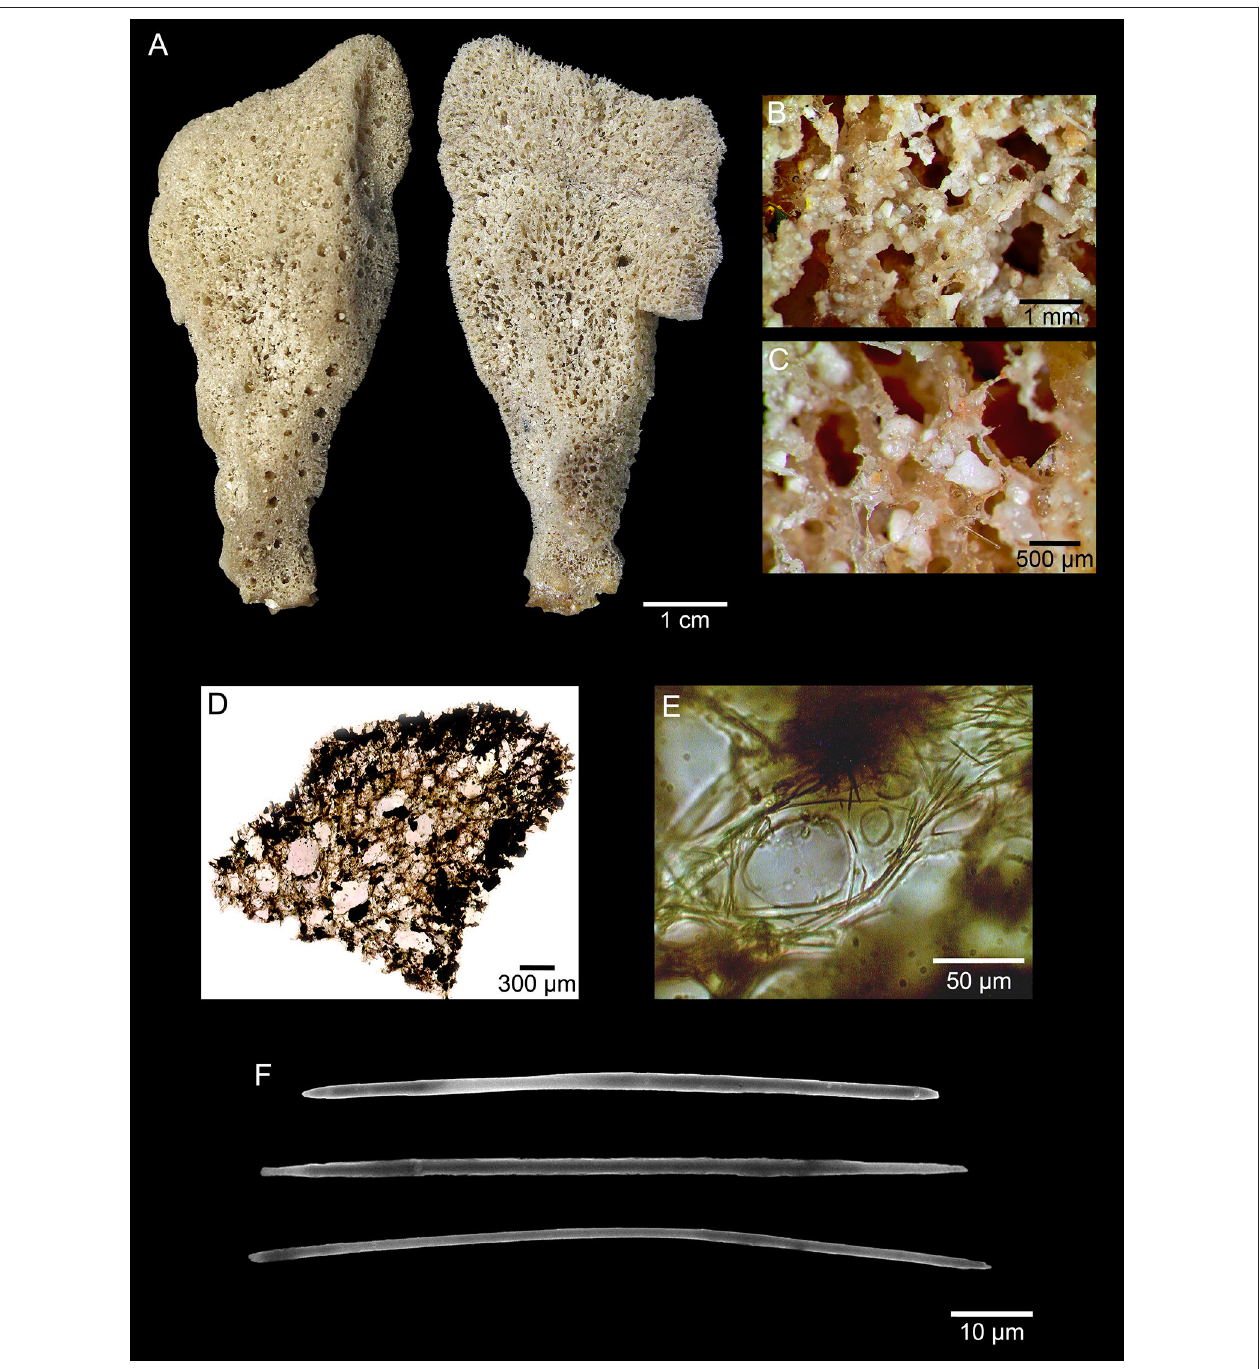
FIGURE 4 | Arenosclera klausi sp. nov. (holotype, MNRJ 18757) morphological and anatomical traits. (A) Both sides of the fixed specimen. (B) Detail of sponge surface. (C) Detail of oscule rim and calcareous debris incorporated to spongin fibers. (D) Ectosome and choanosome transverse section. (E) Detail of choanosome spongin fibers cored by oxeas. (F)